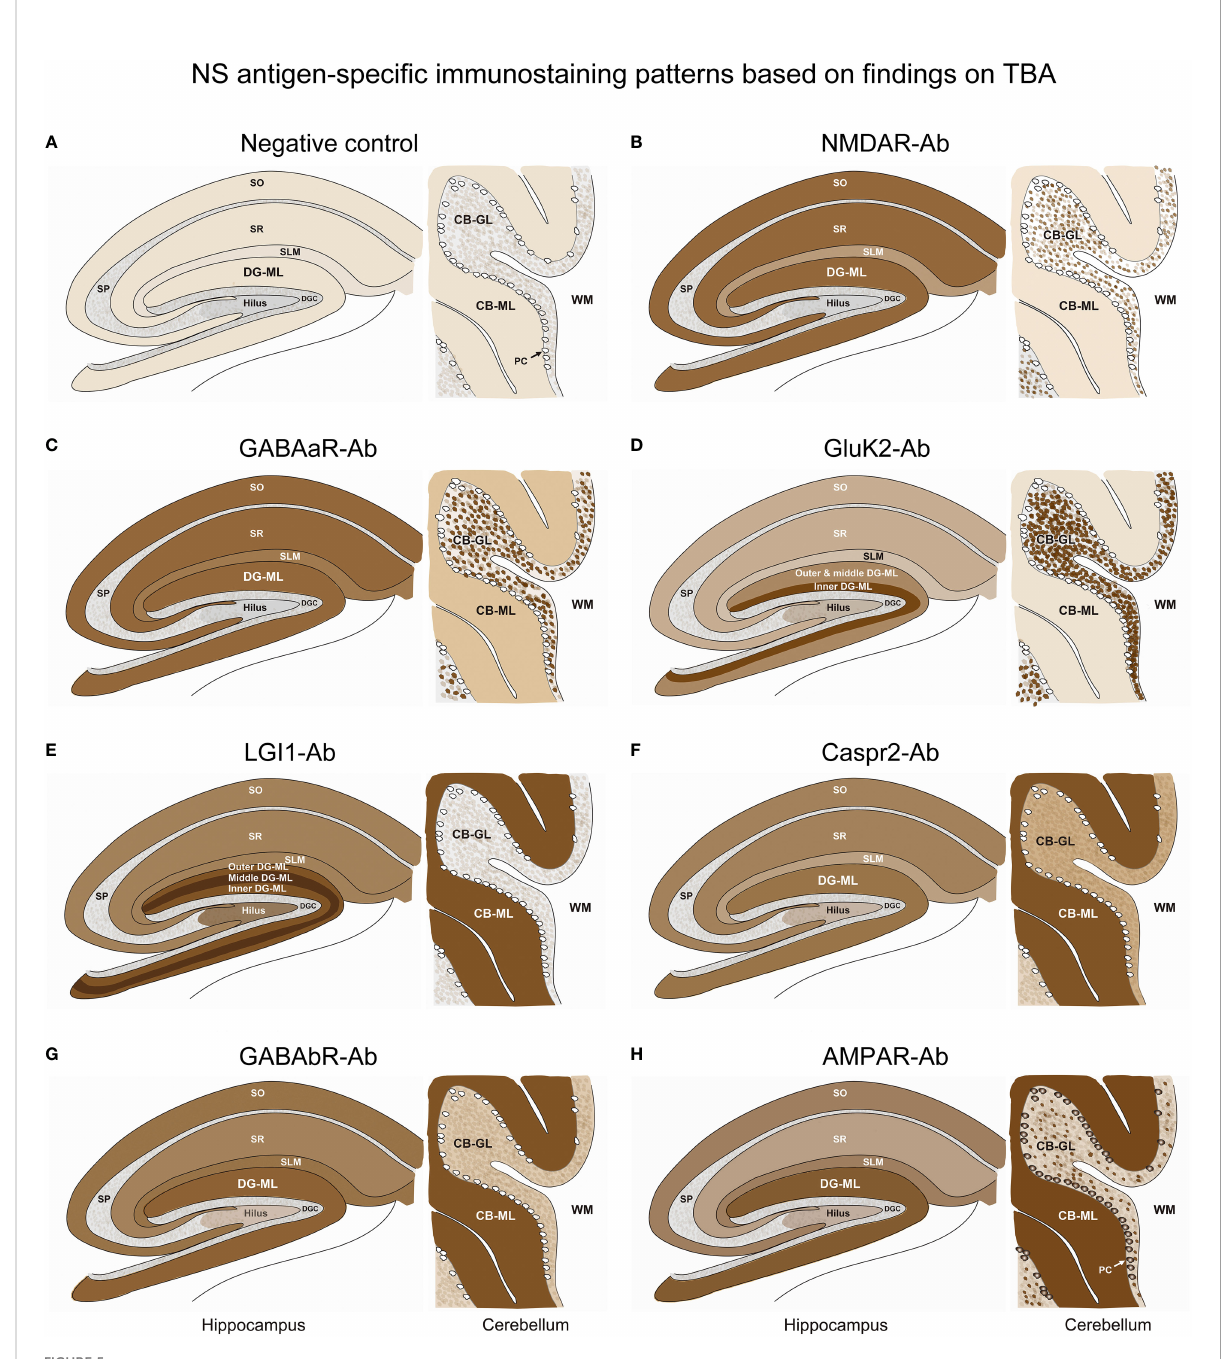
FIGURE 5 A series of illustrations are created as simple as possible to make it easy to follow individual staining pattern at the level of hippocampus and cerebellum. See Text and Figure 4. CB-GL, cerebellar granular layer; CB-ML, cerebellar molecular layer; DGC, dentate granule cells; DG-ML, dentate gyrus molecular layer; PC, Purkinje cells; SLM, stratum lacunosum moleculare; SO, stratum oriens; SP, stratum pyramidale; SR, stratum radiatum; WM, white